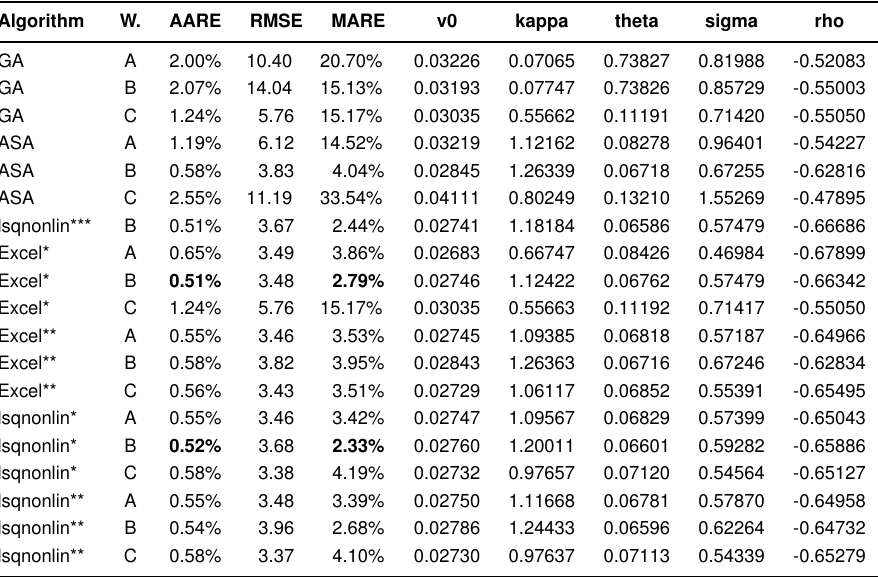
Table 2. Calibration results for March 18, 2013. * denotes initial guess provided by GA. ** indicates initial guess provided using ASA. *** is used for results obtained by deterministic grid.